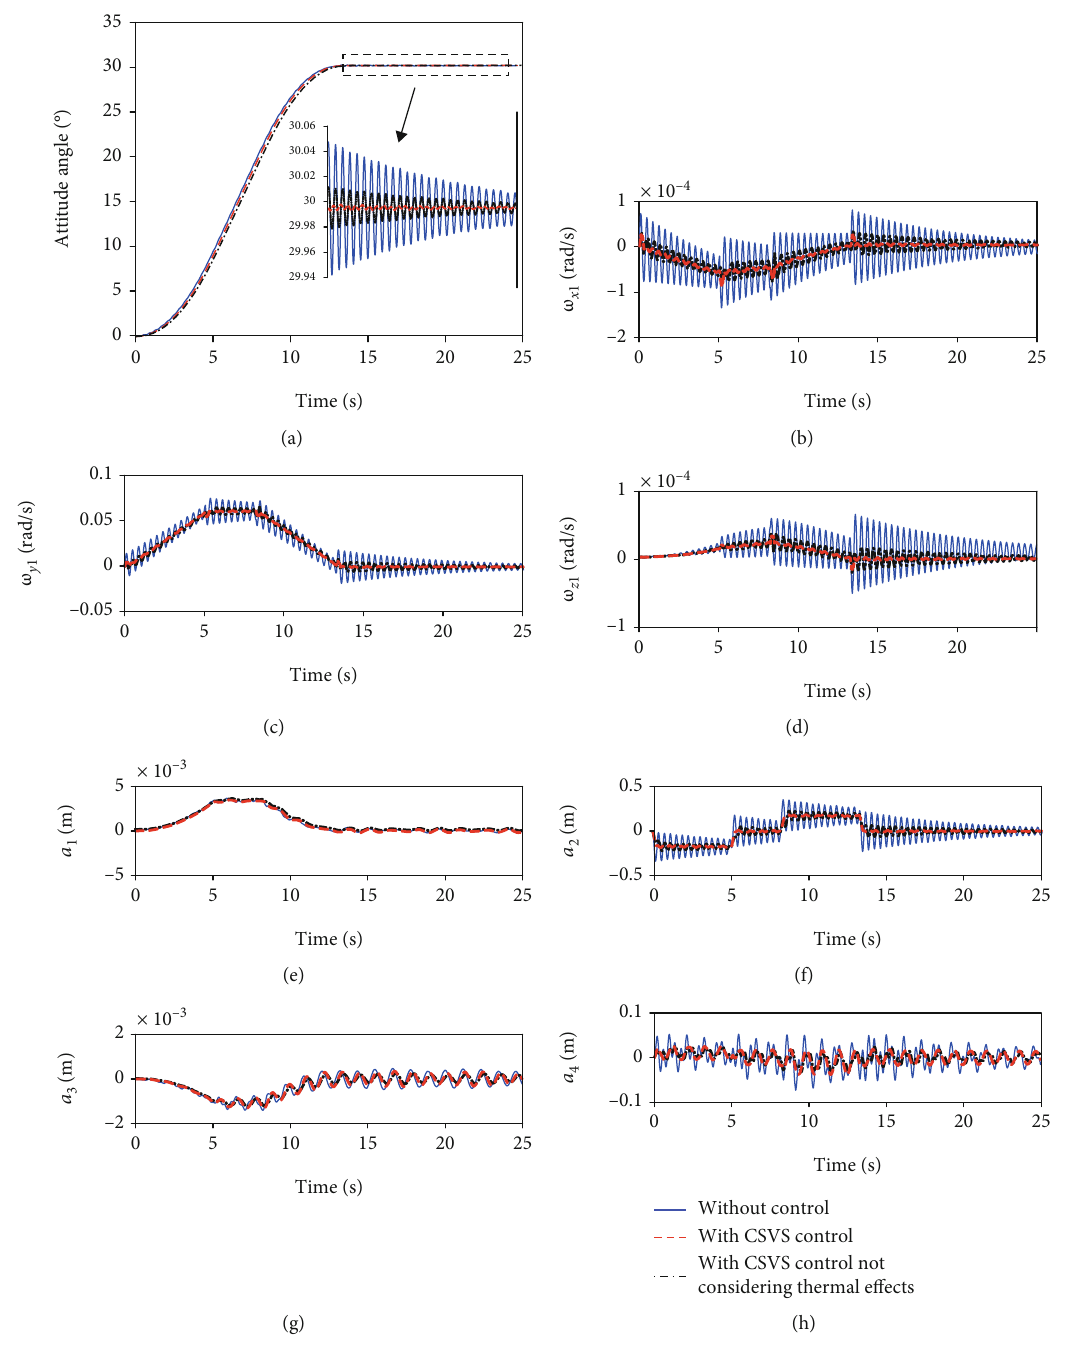
Figure 14: Dynamic response of the satellite-membrane-antenna system during the attitude maneuver with CSVS control: (a) attitude angle; (b) angular velocity in the x direction; (c) angular velocity in the y direction; (d) angular velocity in the z direction; (e) fi rst-order modal 1 1 1 coordinate; (f) second-order modal coordinate; (g) third-order modal coordinate; (h) fourth-order modal